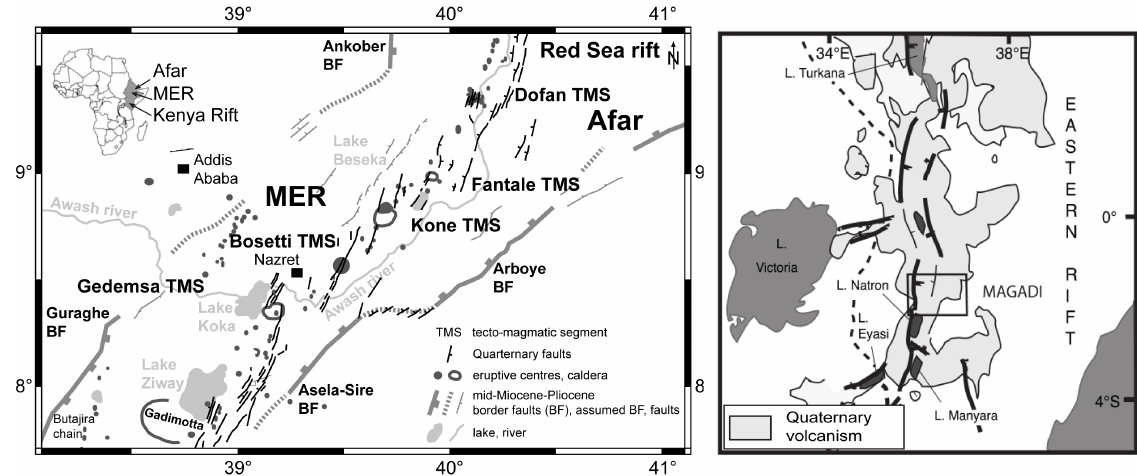
Fig. 1. Localization of the geological area. Left: The Main Ethiopian Rift. Right: The Magadi trough.